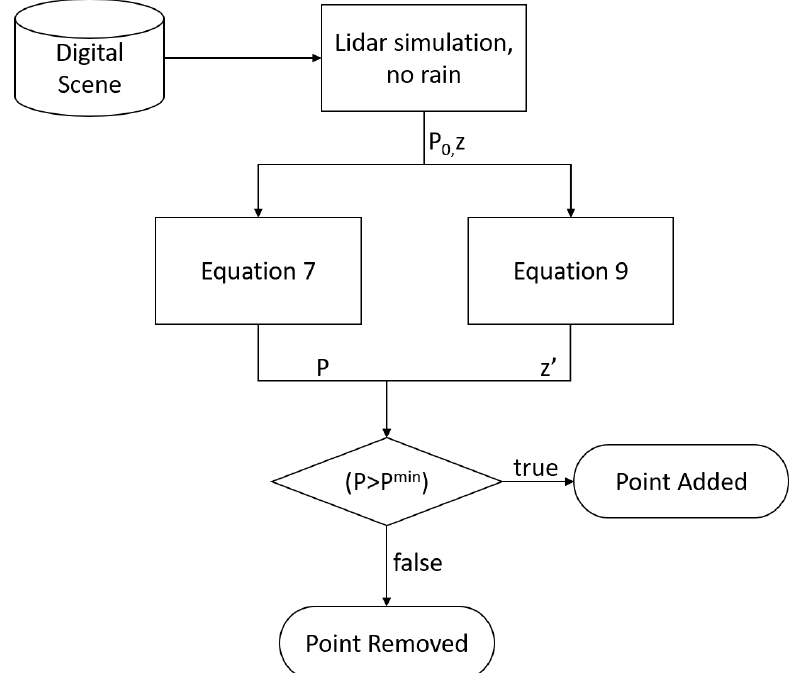
Figure 1. Procedure for modifying LIDAR distances and intensities based on rain